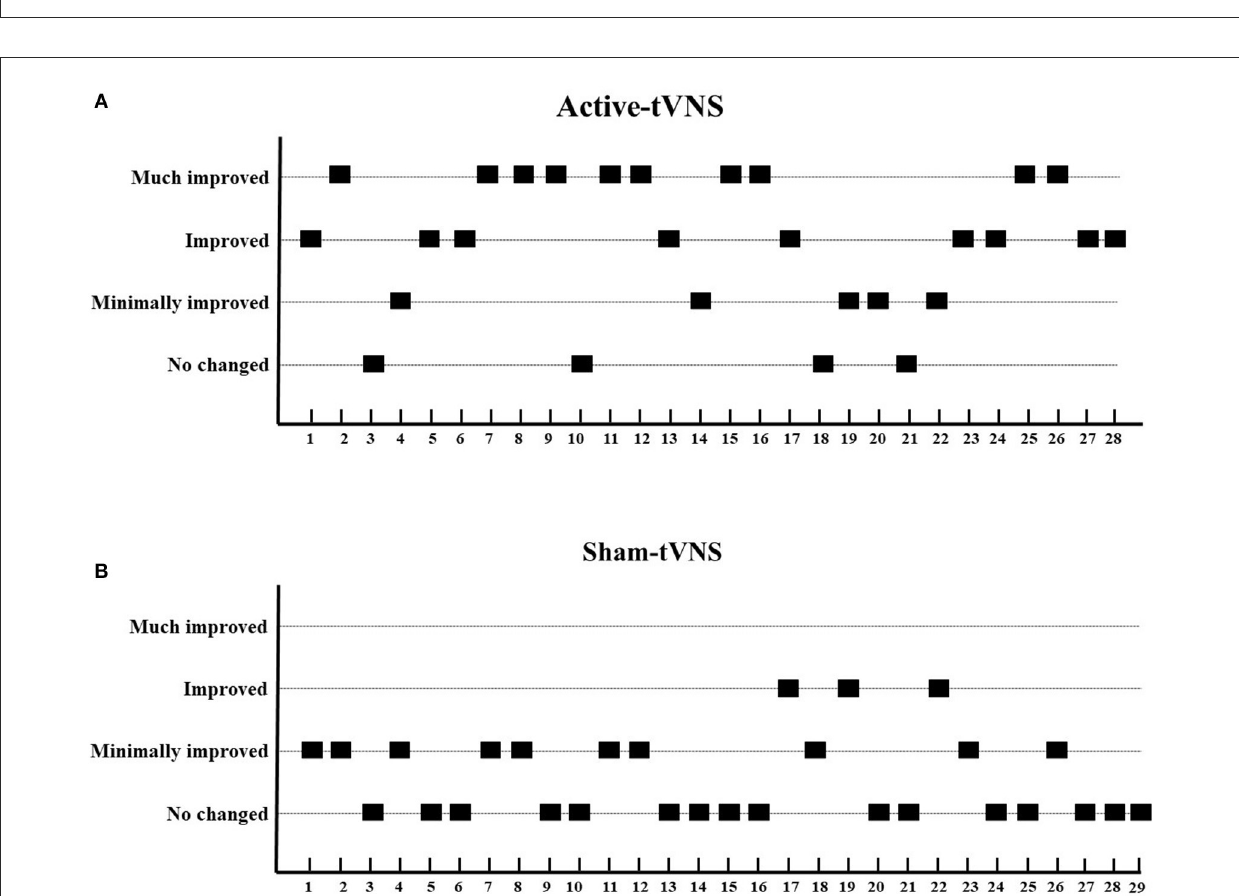
FIGURE3 Improvements in consciousness level between two groups. (A) Active-tVNS group, (B) Sham-tVNS group. We define a CRS-R increase by one point as “minimally improved,” two points as “improved,” and three or more points as “much improved.” Compared with the sham-tVNS group, the active-tVNS group showed greater improvements in